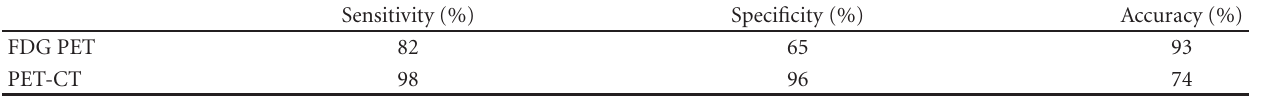
Table 4: Sensitivity and specificity of FDG PET and PET-CT for detecting pelvic recurrence of CRC